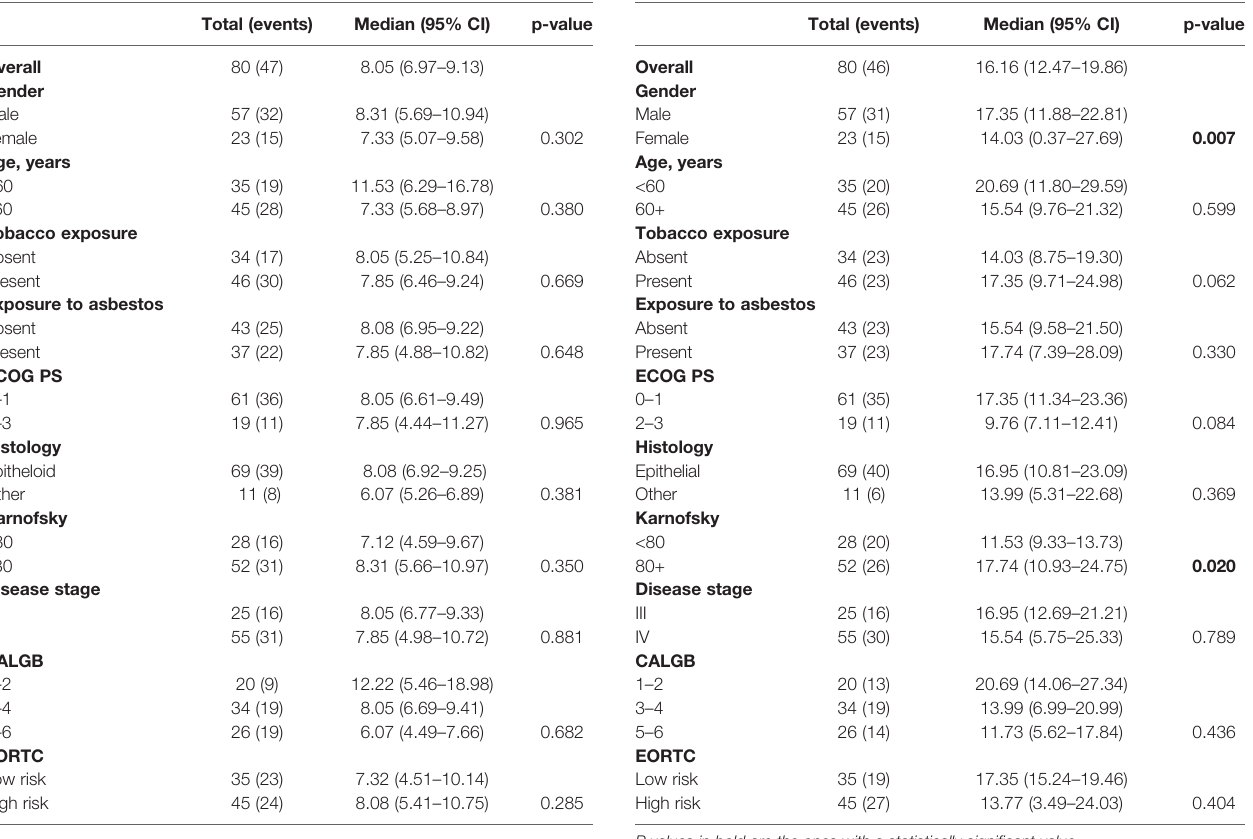
TABLE 3 | Univariate analysis of the factors associated with overall survival to cisplatin/gemcitabine treatment.